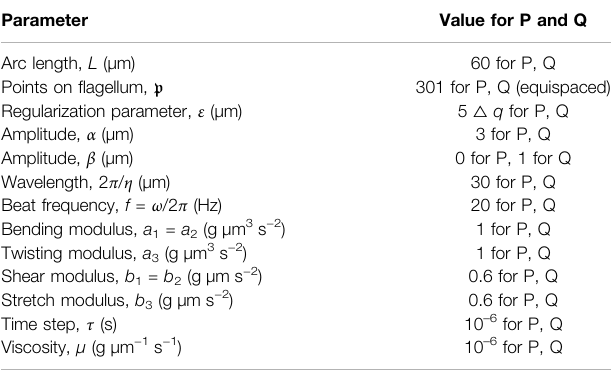
TABLE1| Computationalparametersforpreferredplanar (P)andquasi-planar(Q) beat forms. Parameter Value for P and